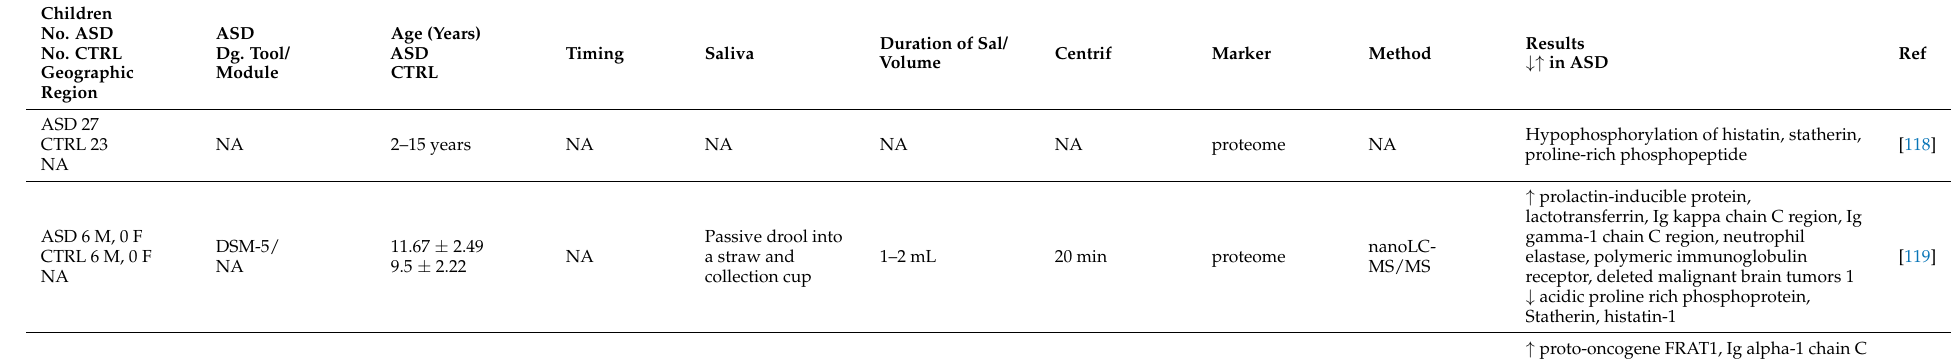
Table 3. Protein and inflammatory markers in